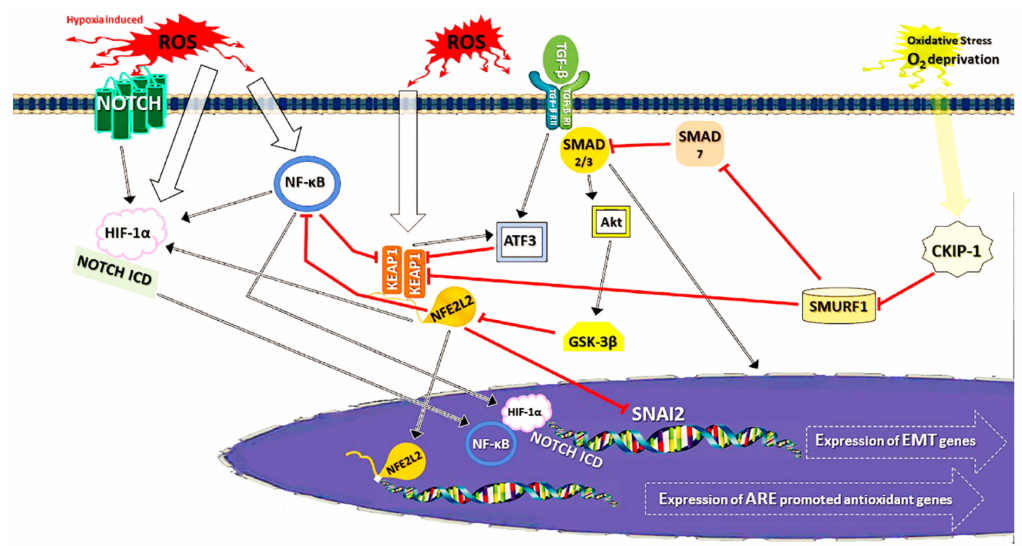
Figure 4. The currently known links between NFE2L2 signalling and epithelial-to-mesenchymal transition (EMT). These links are explained in detail in the text. Abbreviations: ATF3, activating transcription factor 3; CKIP-1, casein kinase 2 interacting protein-1; SNAI2, Snail family Zn-finger transcription factor 2. Other abbreviations are detailed in the list of